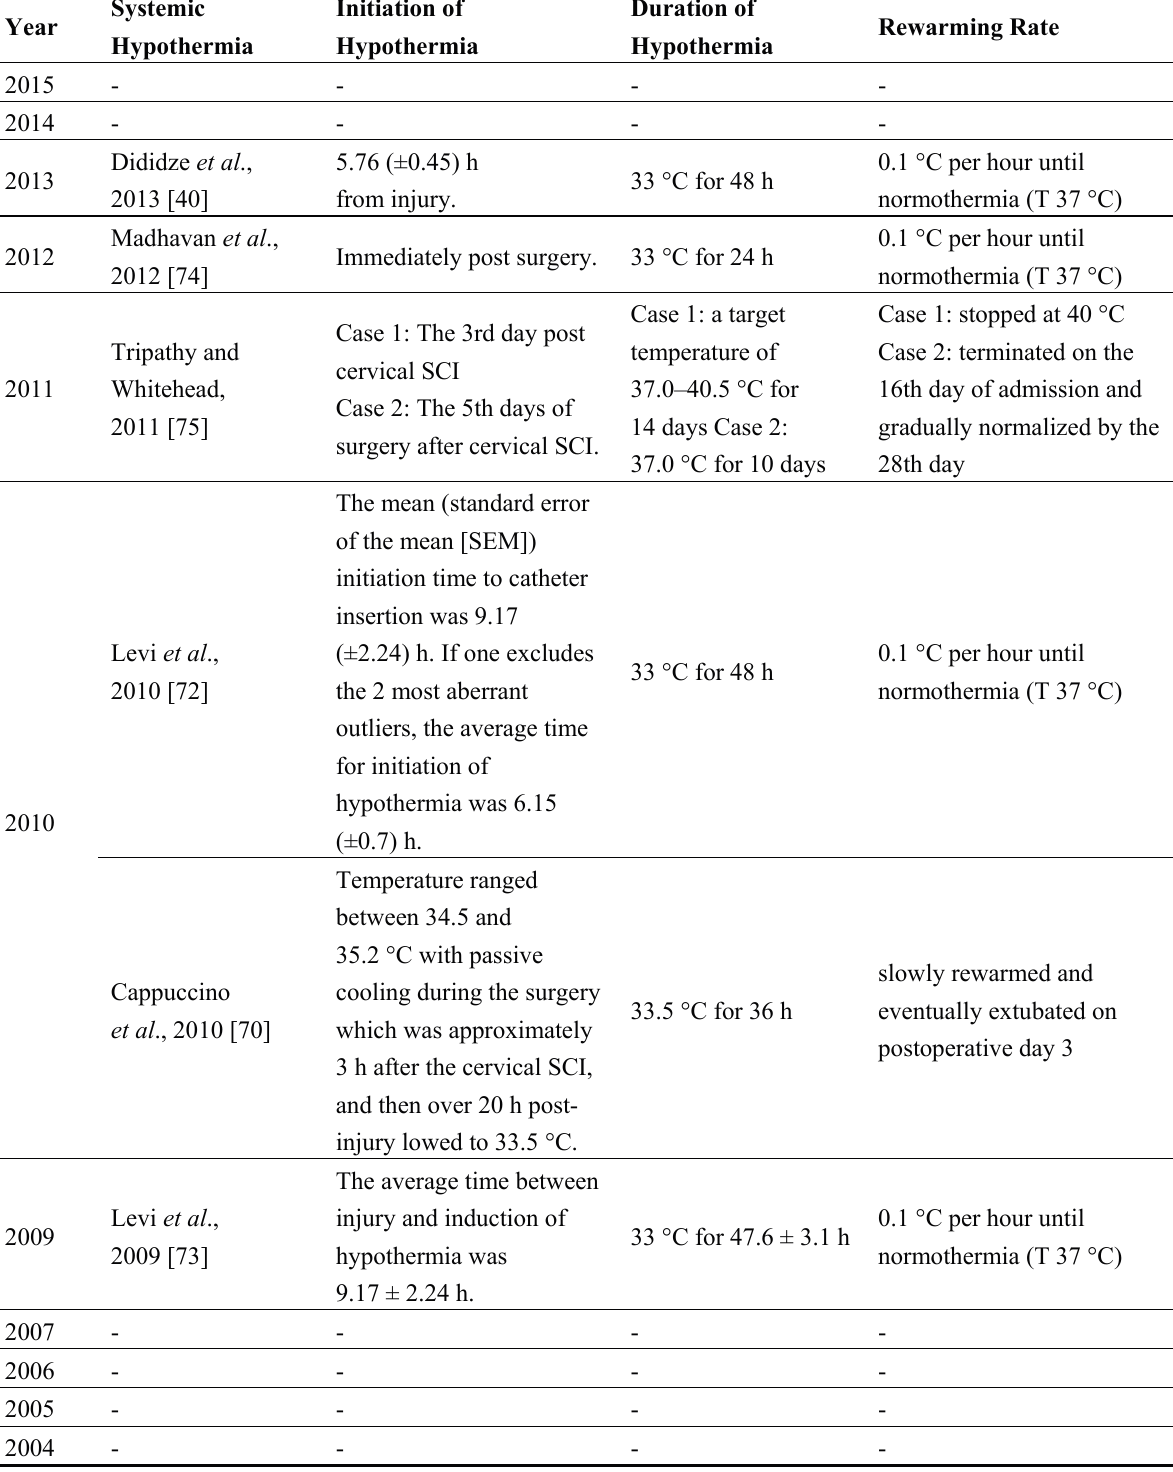
Table 1. Initiation, duration and rewarming rate for systemic hypothermia in human SCI